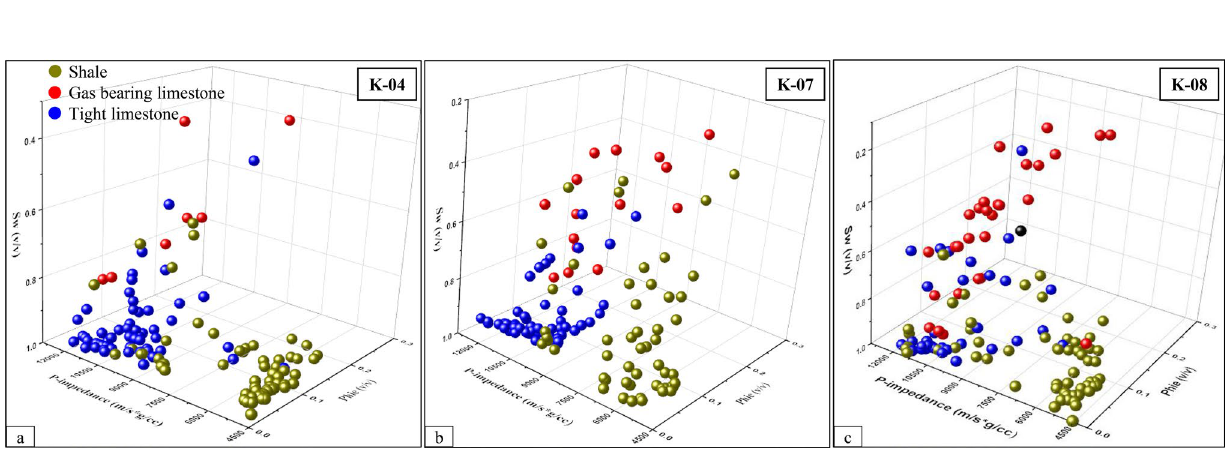
Fig. 9 Facies classification of three wells. 3D cross-plots of p -impedance versus water saturation (Sw) and effective porosity (Phie) of the target reservoir (S1) color coded with lithology